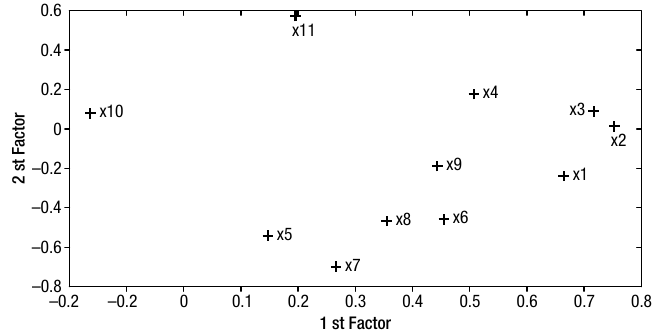
Fig. 5. Factor loadings obtained after normalized quatrimax rotational strategy